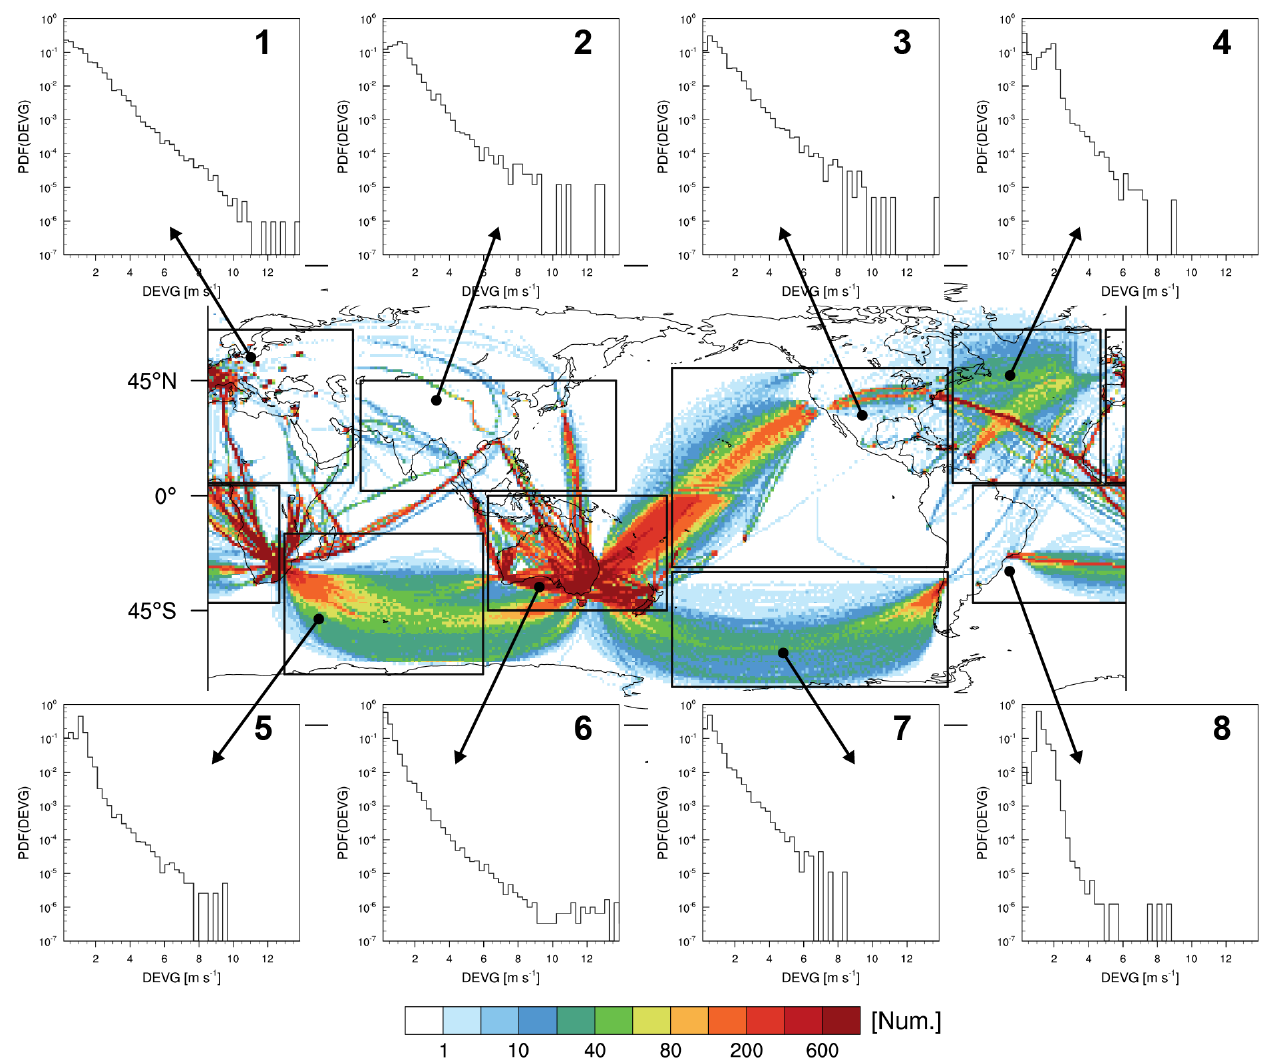
Figure 8. Horizontal distribution of the number of the QCDEVG data at altitudes above 15kft ( ∼ 4 . 57km), accumulated within a 1 ◦ × 1 ◦ horizontal grid box from October 2015 to September 2018. The PDFs of the QCDEVG over eight selected regions, superimposed on the global map by rectangles.